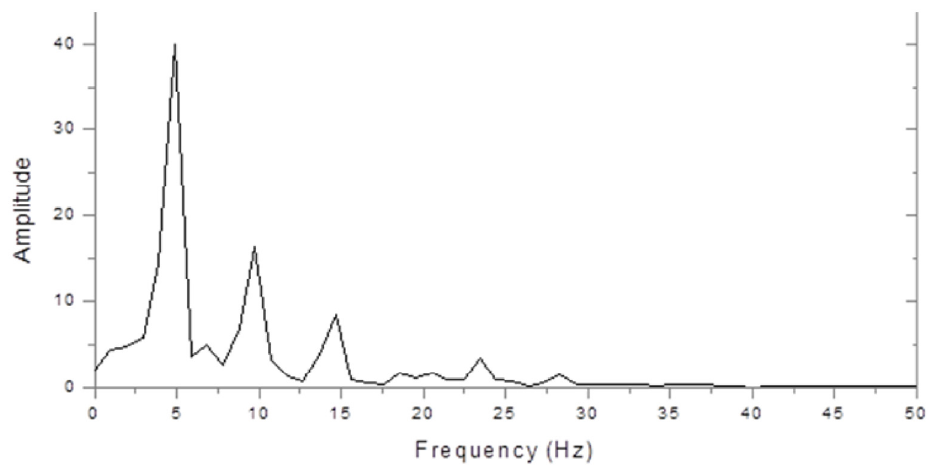
Figure 2. Dyslexic steady state VERP spectrum (microvolts/hertz).